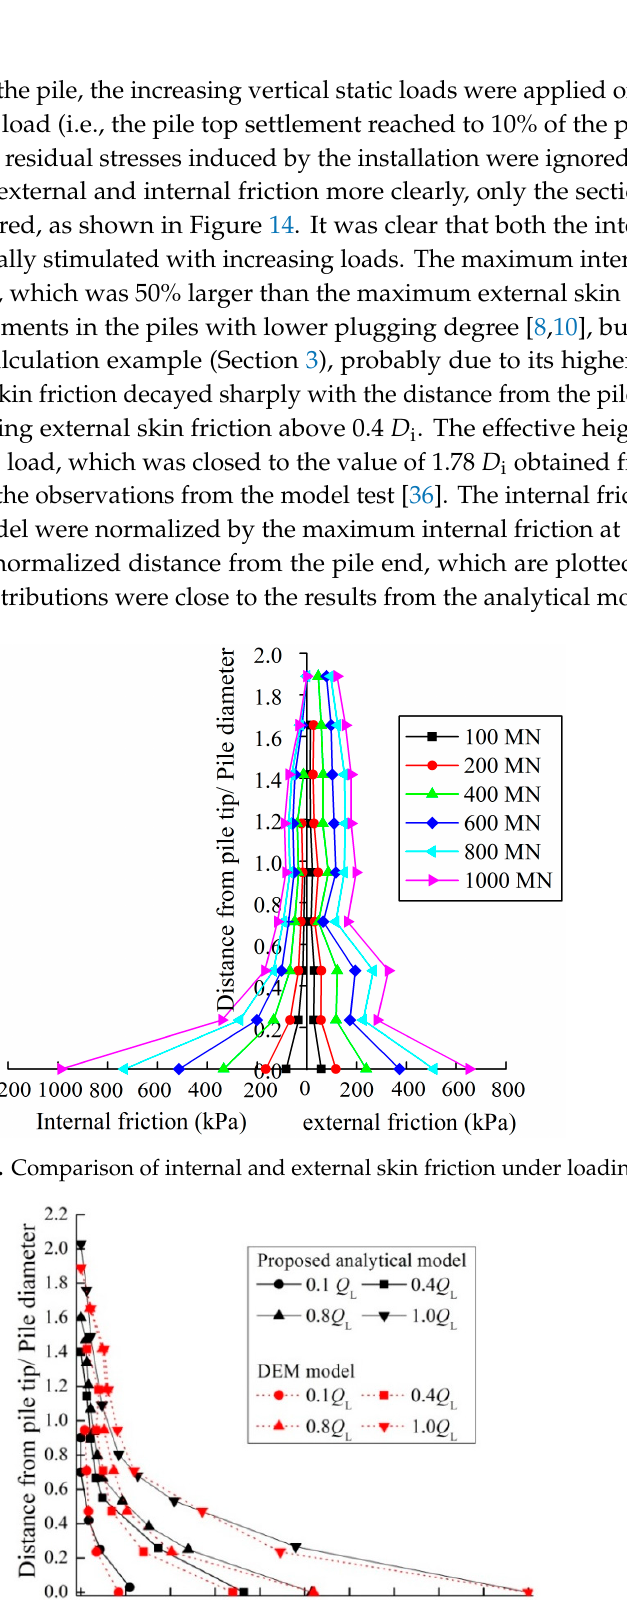
Figure 13. View of pile-soil system just after installation.